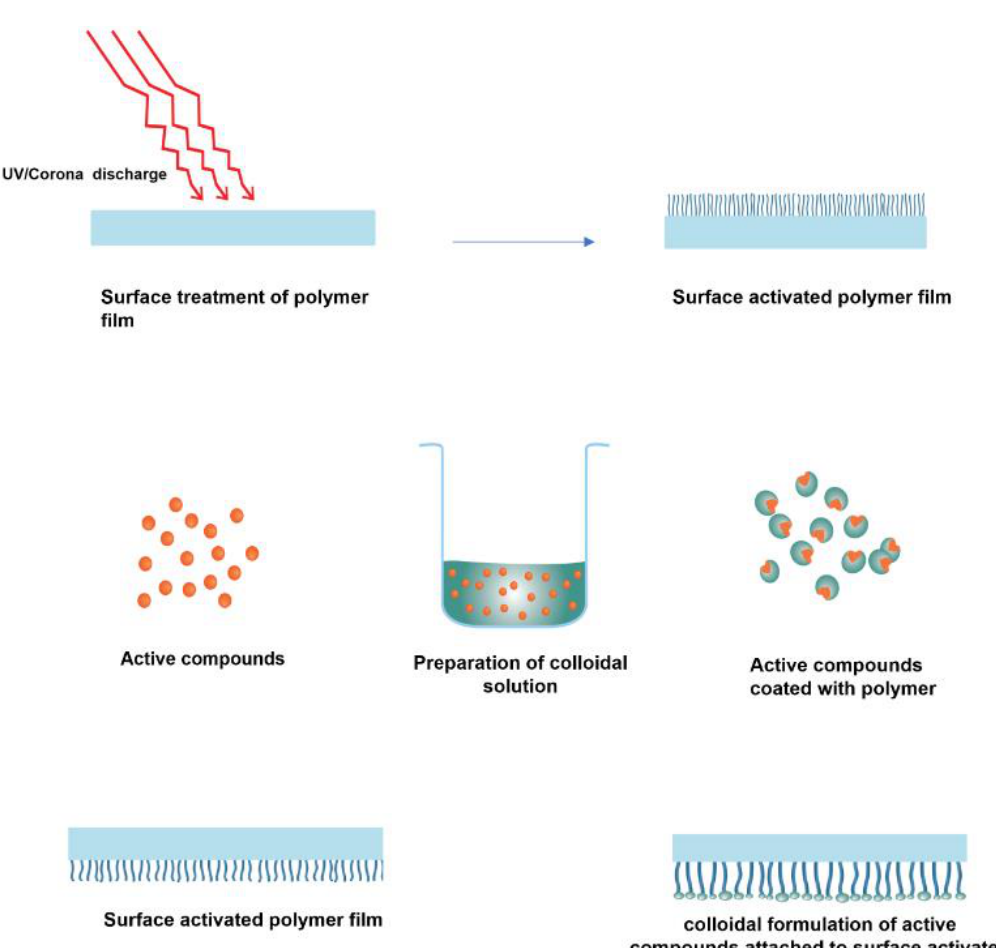
Figure 9. Surface immobilisation methods.